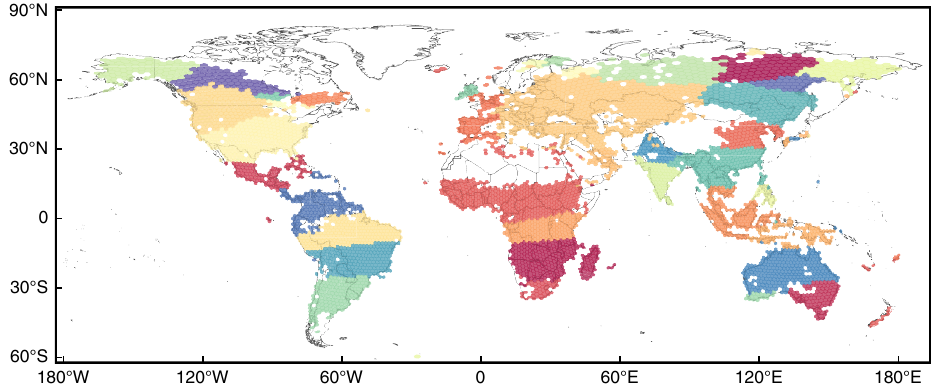
Fig. 7 Communities in the pruned chronnet constructed with the wild fi re data set. Only 20% of strongest links were considered and 1% of the largest degree nodes were removed (outliers). Communities were achieved using the label propagation method 40 . Colors represent the